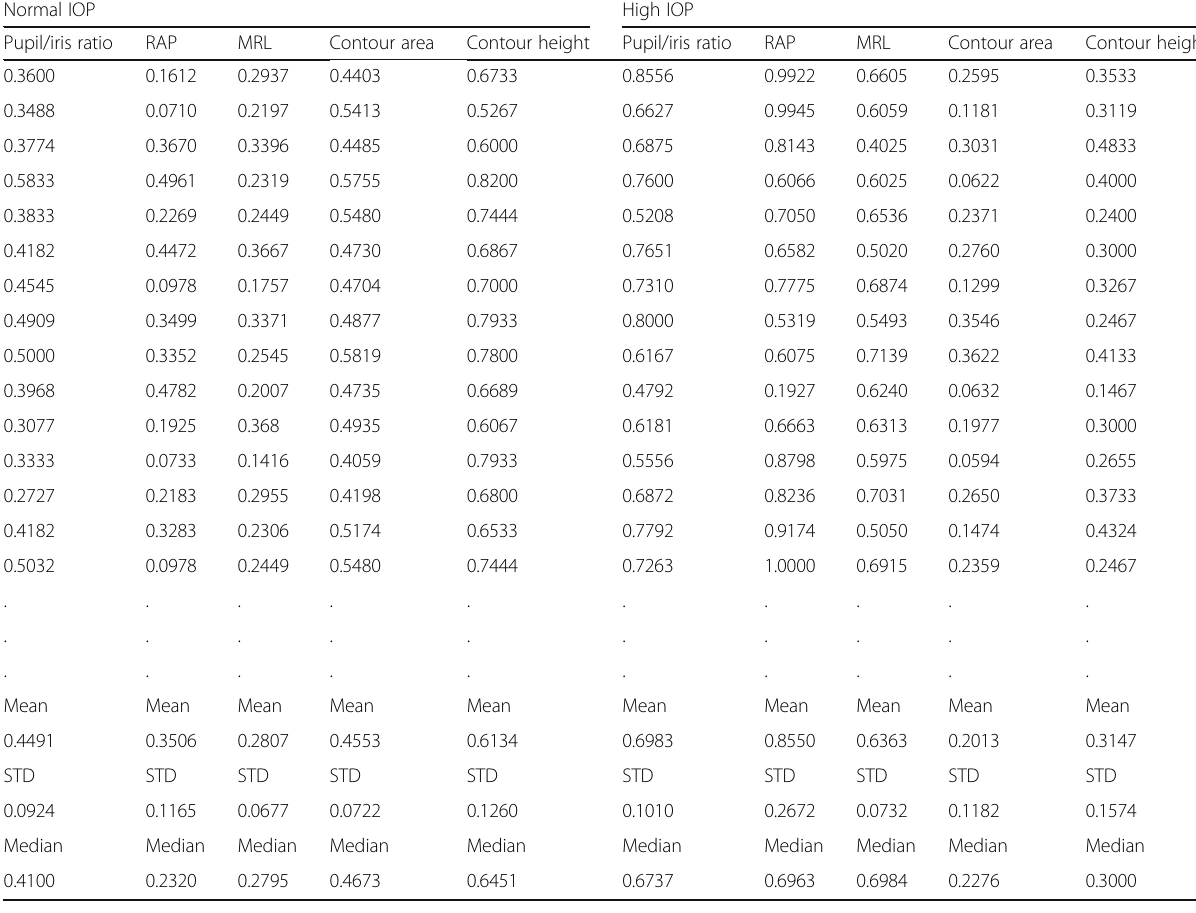
Table 4 Sample values of pupil/iris ratio, MRL, RAP, and contour feature (area, height) results for normal, high eye pressure Normal IOP High IOP Pupil/iris ratio